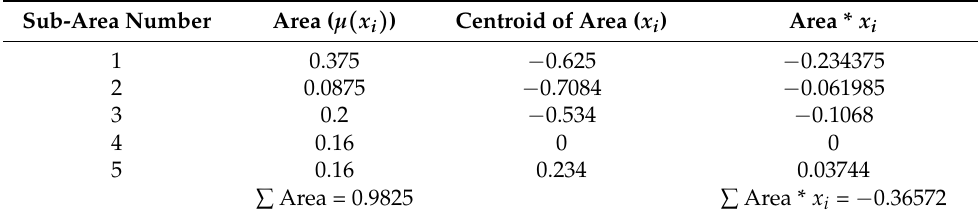
Table 1. Result of each sub-area and centroid related to example